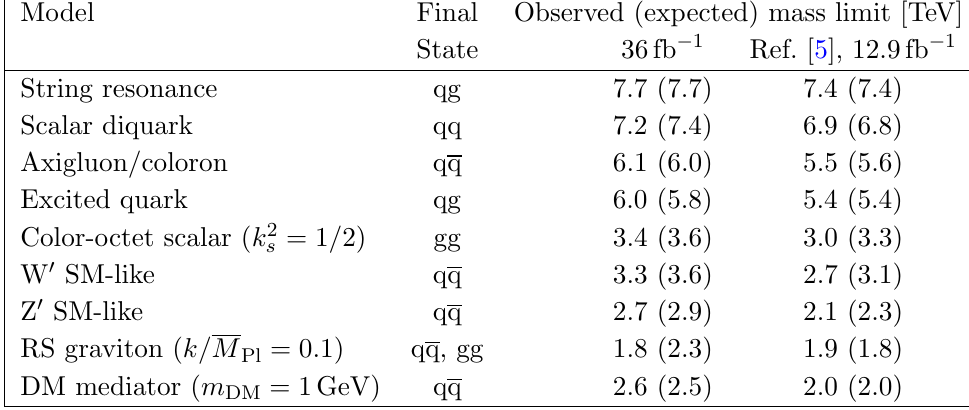
Table 3 . Observed and expected mass limits at 95% CL from this analysis compared to previously published limits on narrow resonances from CMS with 12.9 fb (cid:0) 1 [5]. The listed models are excluded between 0.6 TeV and the indicated mass limit by this analysis. In addition to the observed mass limits listed below, this analysis also excludes the RS graviton model within the mass interval between 1.9 and 2.5 TeV and the Z 0 model within roughly a 50 GeV window around 3.1